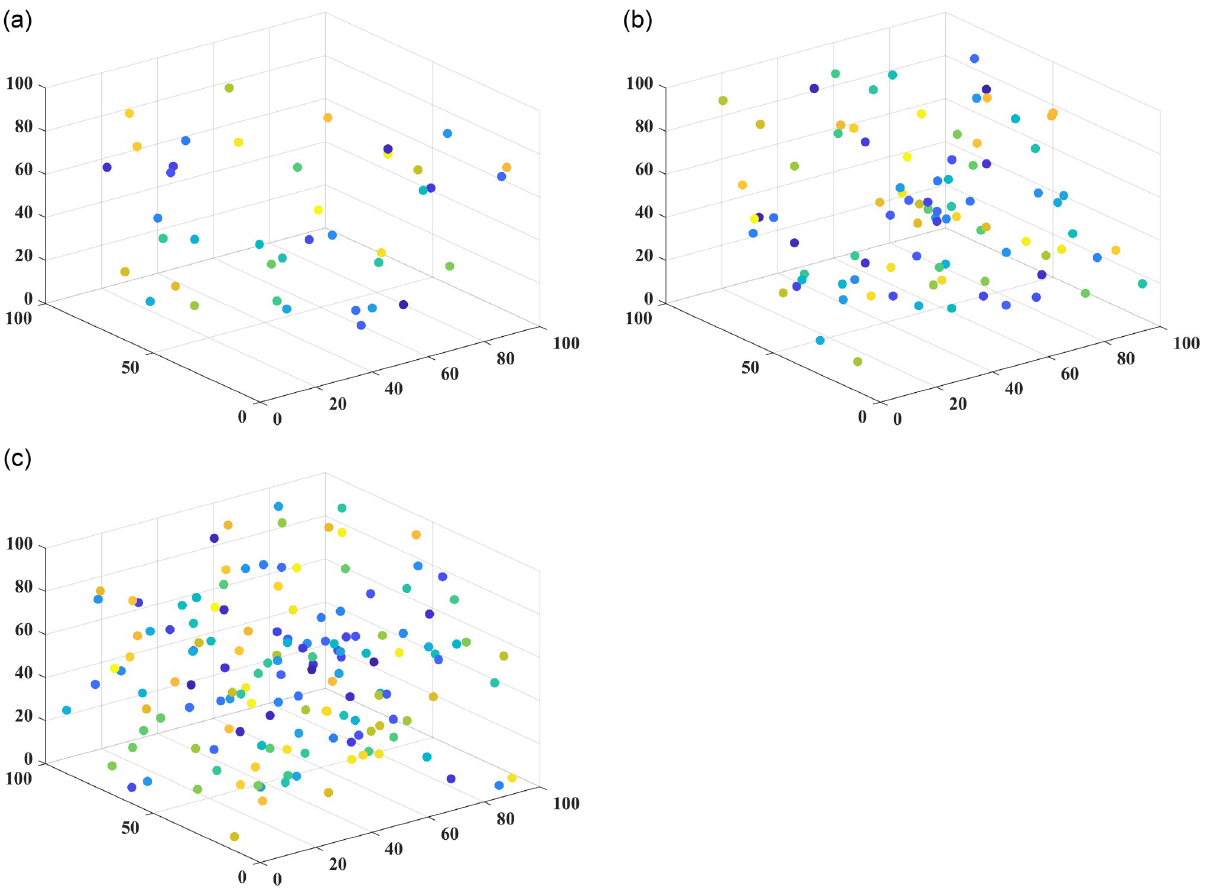
Fig 5. Fruit coordinate points at different